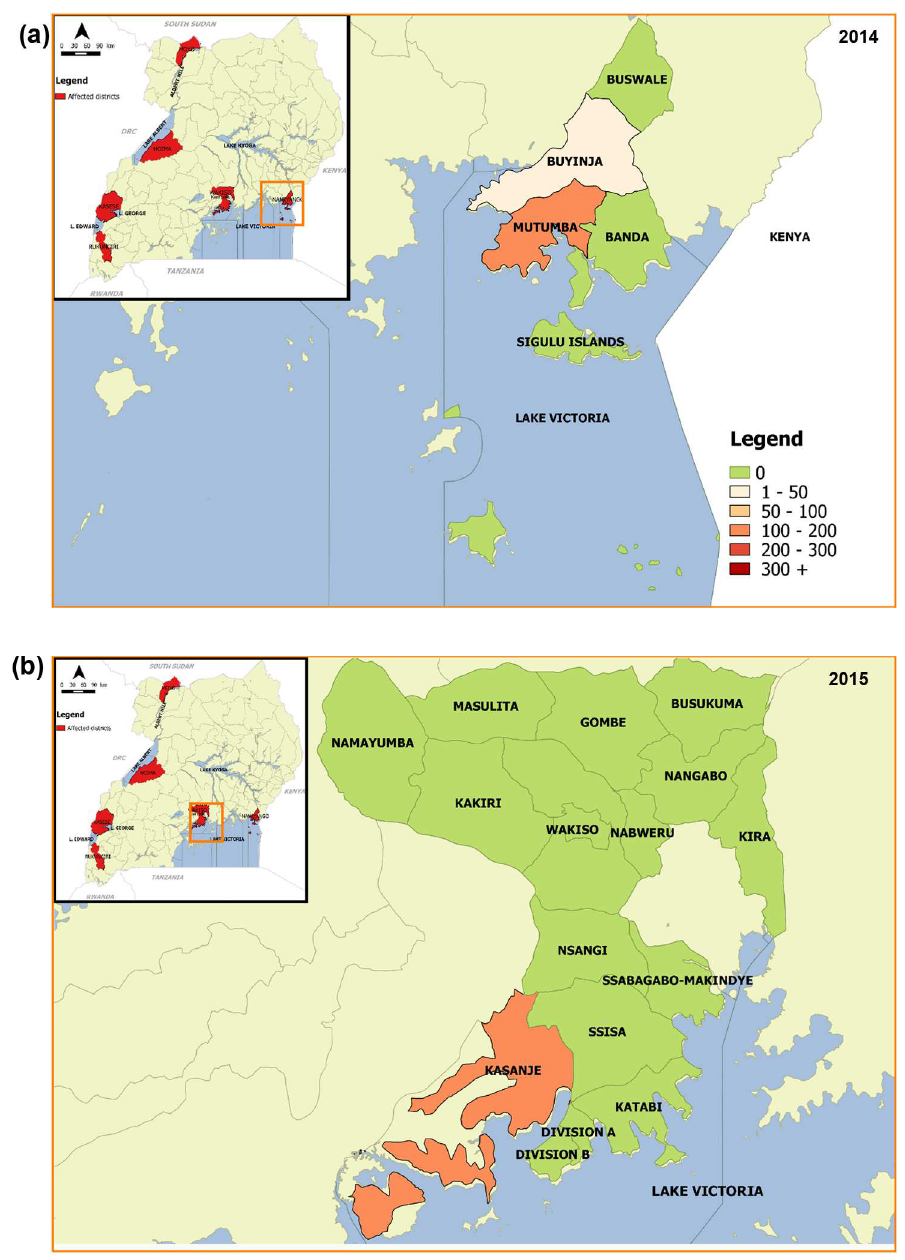
Fig 5. Cholera outbreaks that occurred along Lake Victoria. Fig 5a: Choleraoutbreakin Namayingo district, 2014; Fig 5b: Choleraoutbreakin Wakiso district,